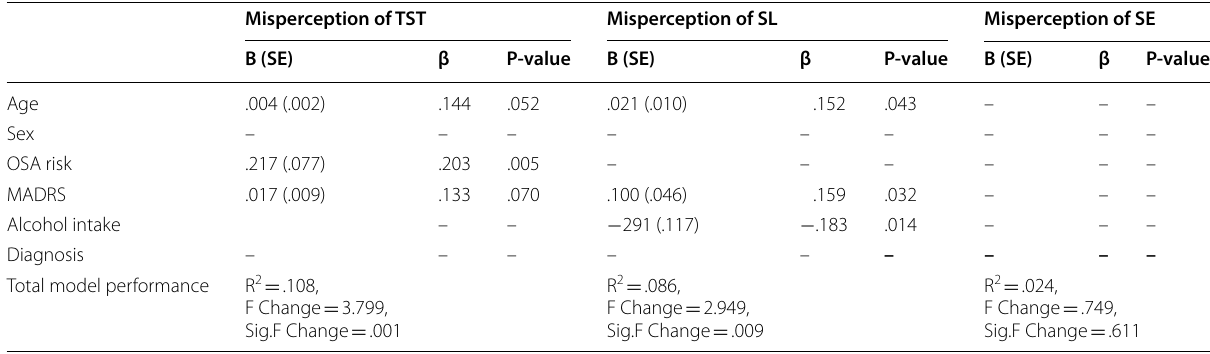
All independent variables entered, only significant and trend-significant values given in table MADRS Montgomery and Asberg Depression Rating Scale, OSA risk any positive score related to obstructive sleep apnea on The Berlin